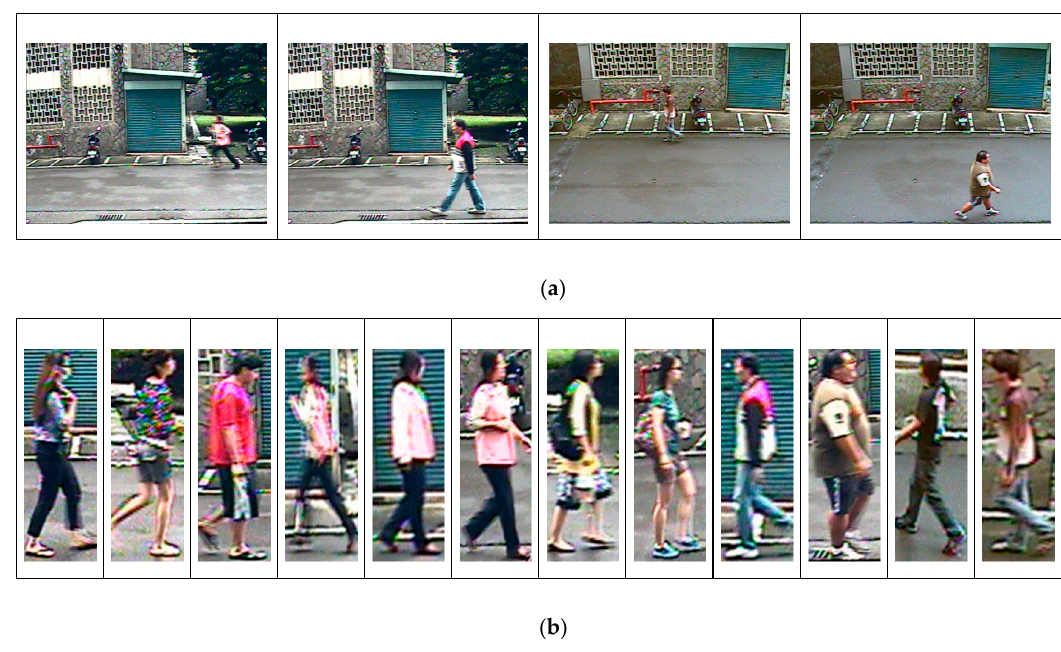
Figure 6 . The experimental video scenes. ( a ) Experimental videos and ( b ) moving objects in experimental videos.